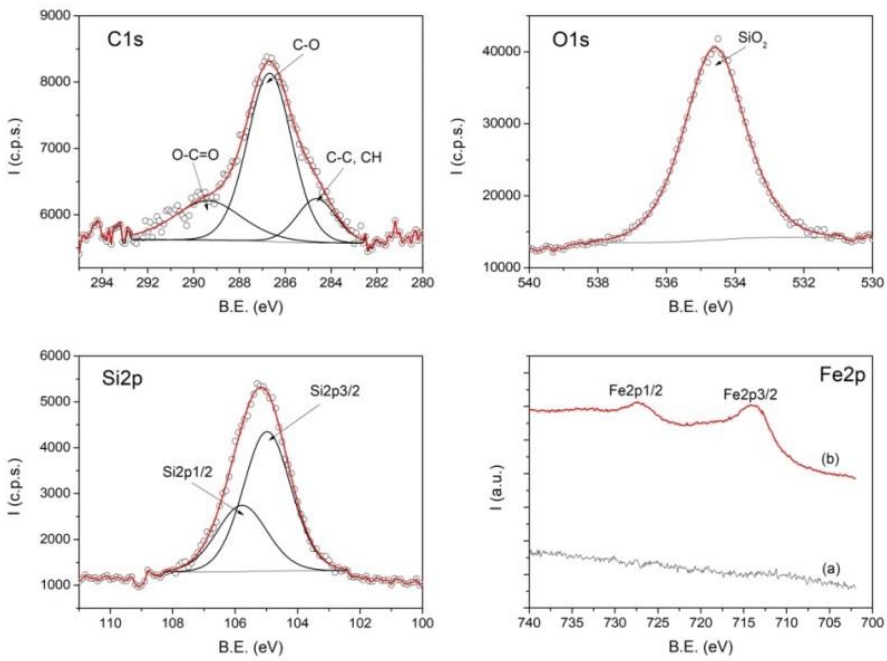
Figure 3. High-resolution XPS spectra of C1s, O1s, Si2p and Fe2p (spectrum (a) before sputtering; spectrum (b) after sputtering at 2000 V 180 min) from the sample Fe 3 O 4 -SiO 2 .